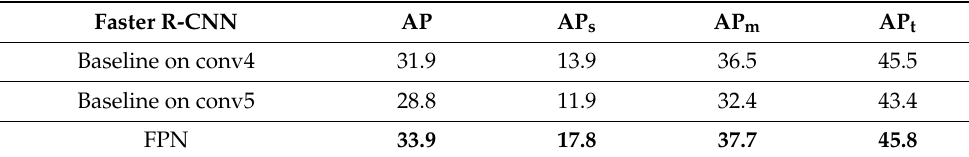
Figure 10. Framework for the FPN [9]. Table 4. Differences using the